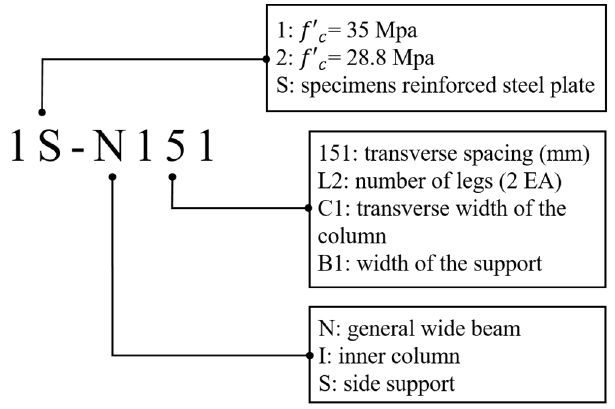
Figure 3. Notation of specimens. Table 2. Grouping and details of the experiment specimens.